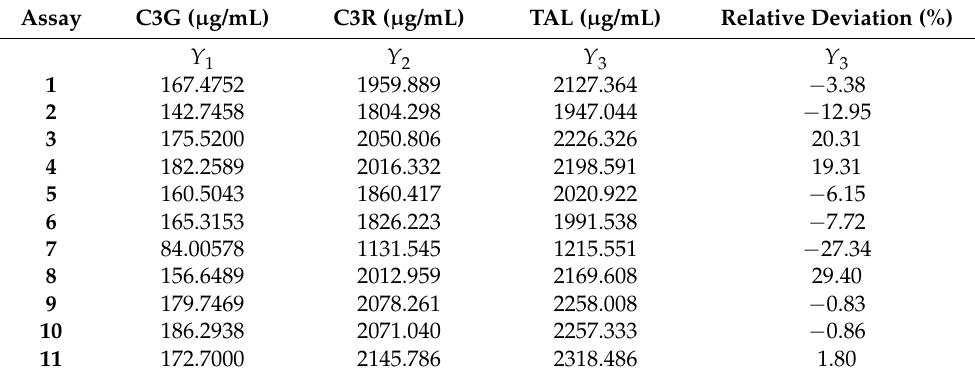
Table 5. Experimental values for C3G, C3R, and TAL extracted by CH-Xyl in the CCRD assays, and relative deviation (%) among experimental and predictive values of TAL.